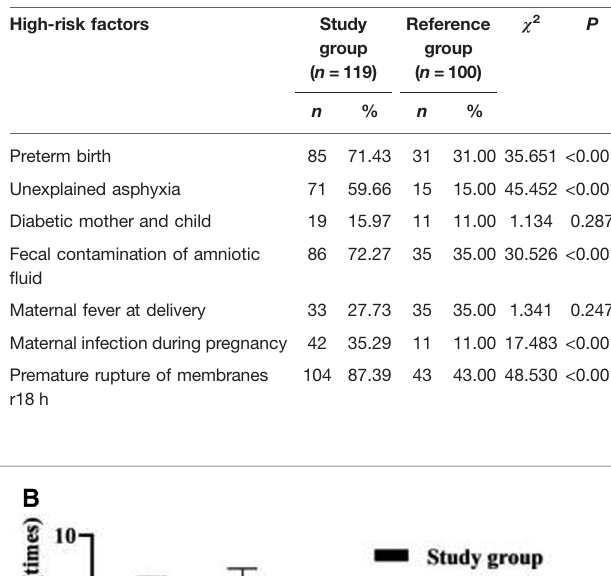
TABLE 1 | Univariate analysis of EONBI and obstetric high-risk